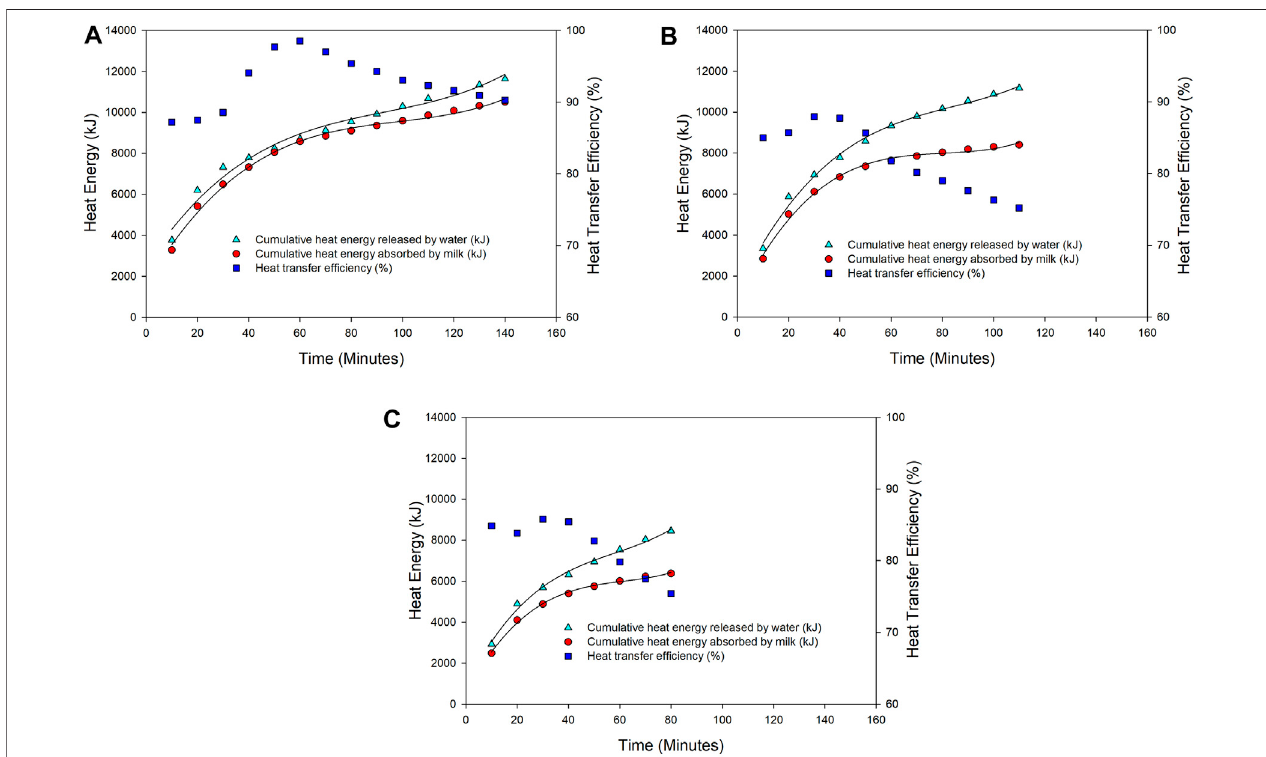
FIGURE 3 | Total heat energy released by water and absorbed by milk during the processing of 50 L (A) , 40 L (B) , and 30 L (C) milk.